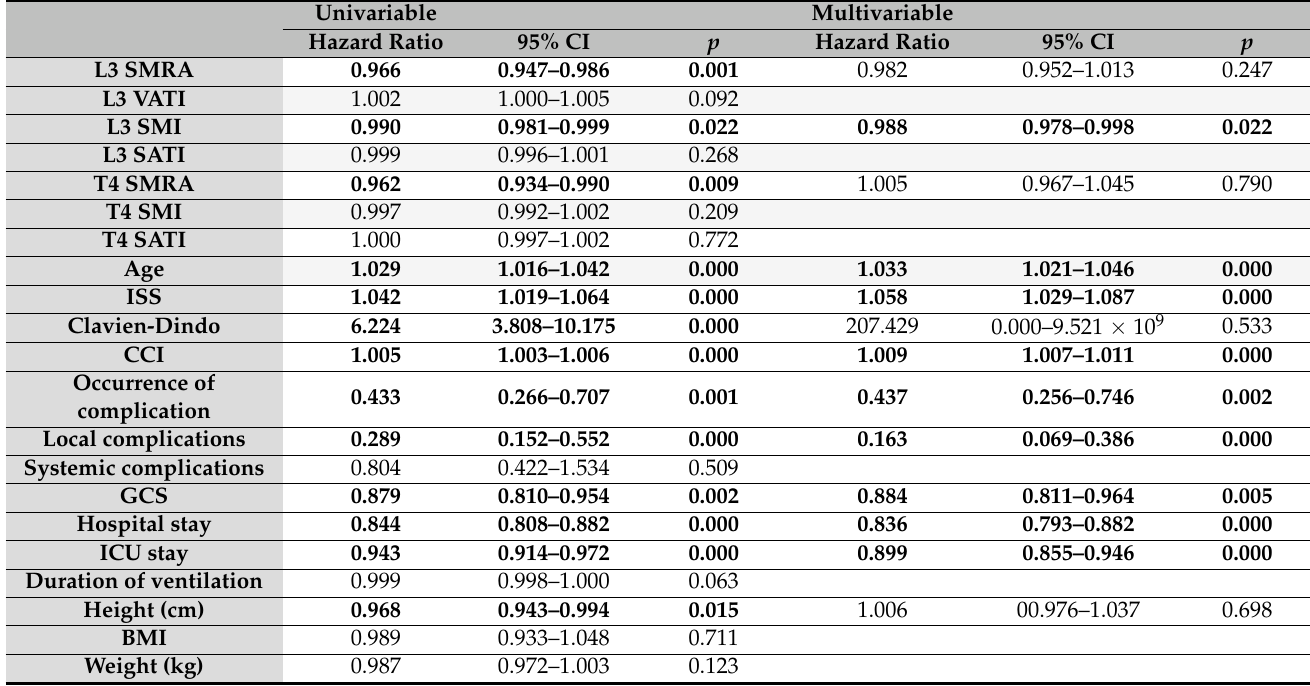
Table 5. Regression models of BC parameters with regard to overall